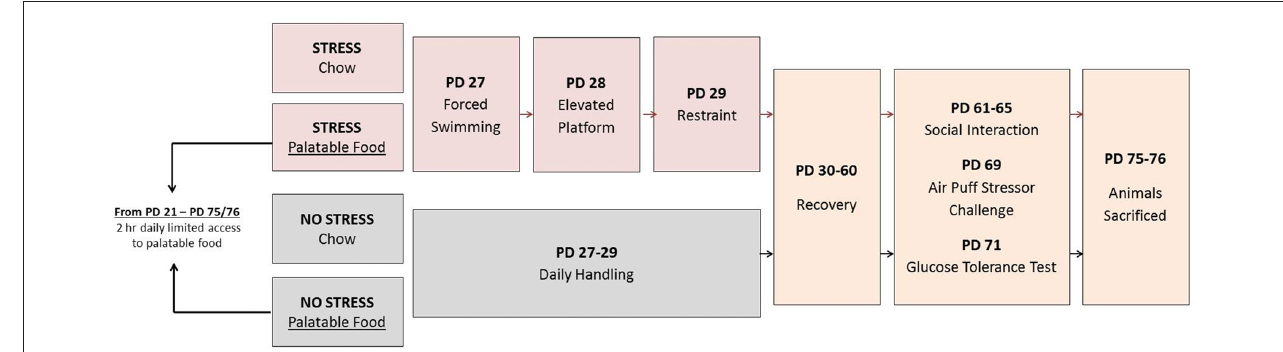
FIGURE 1 | Singly housed animals were assigned to four groups: (1) Chow + Stress; (2) Palatable + Stress; (3) Chow + No Stress and (4) Palatable + No Stress. Groups assigned to the stressor condition were exposed to a different episodic stressor per day from postnatal days (PD) 27–29 while non-stressed animals received daily handling. The following were evaluated in adulthood: Group 1—40 animals ( n = 10 per group) were tested for behavior (social interaction), adiposity and gene expression. Group 2—48 animals ( n = 12 per group) were tested for hypothalamic-pituitary-adrenal (HPA) activity after an acute stressor (air-puff) and for glucose